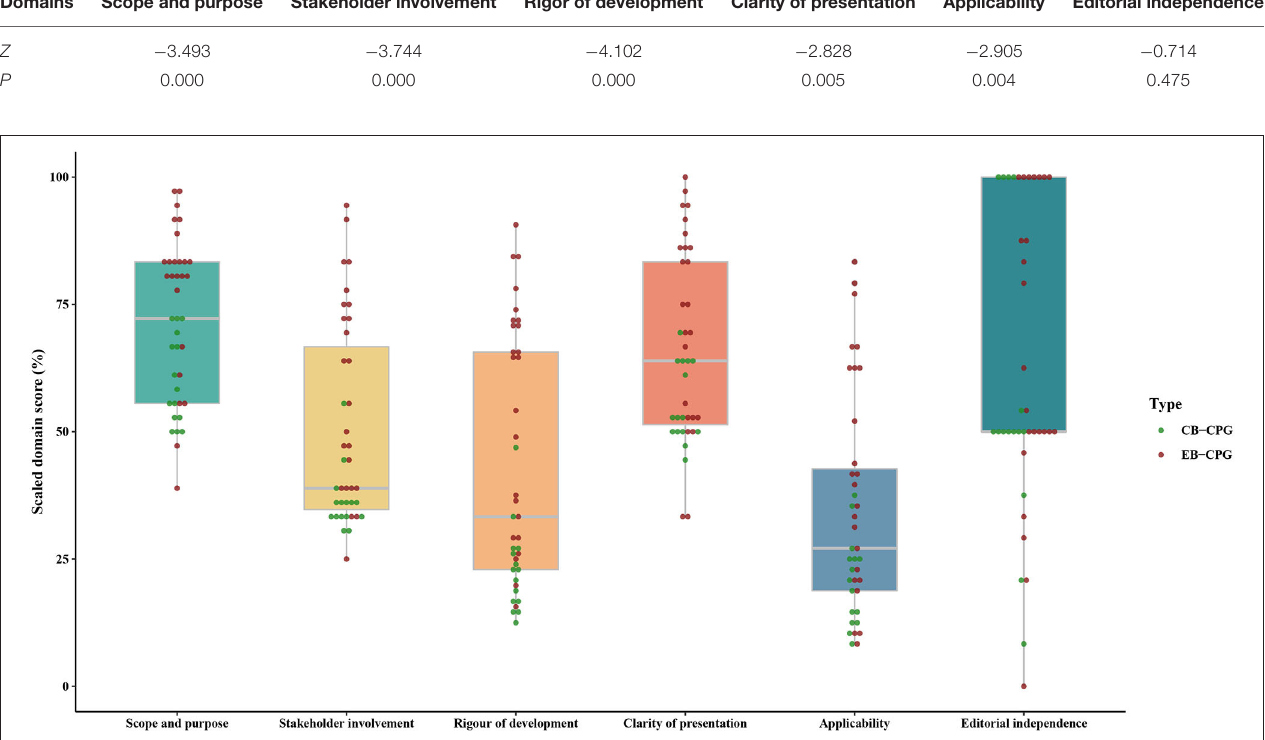
FIGURE 3 | The summary of scores for each domain over all included